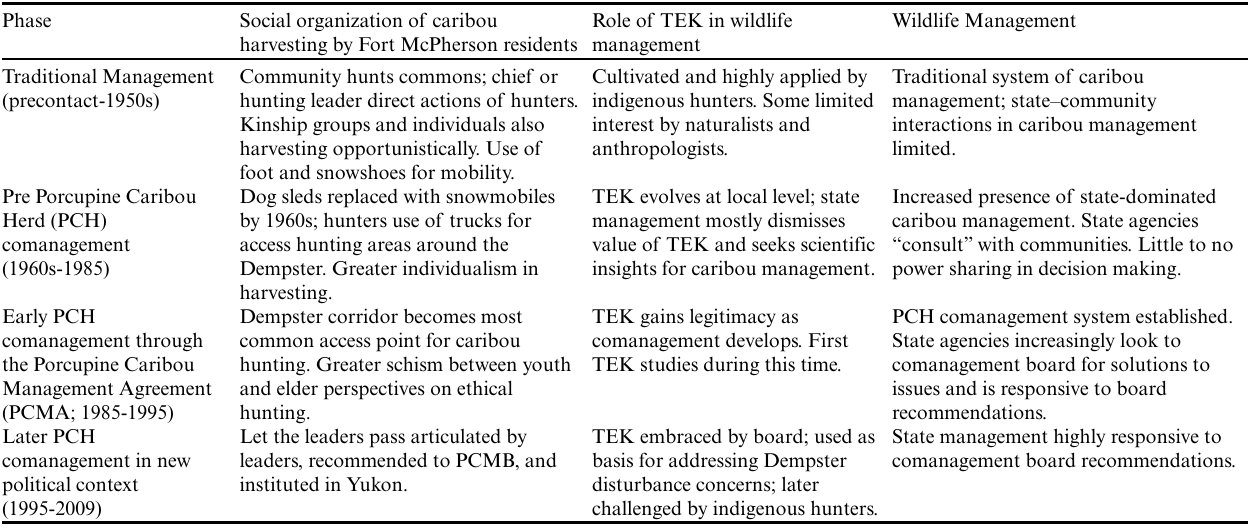
Table 1 . Phases of caribou management with respect to the Dempster Highway and changes in social organization, role of traditional ecological knowledge (TEK), and wildlife management